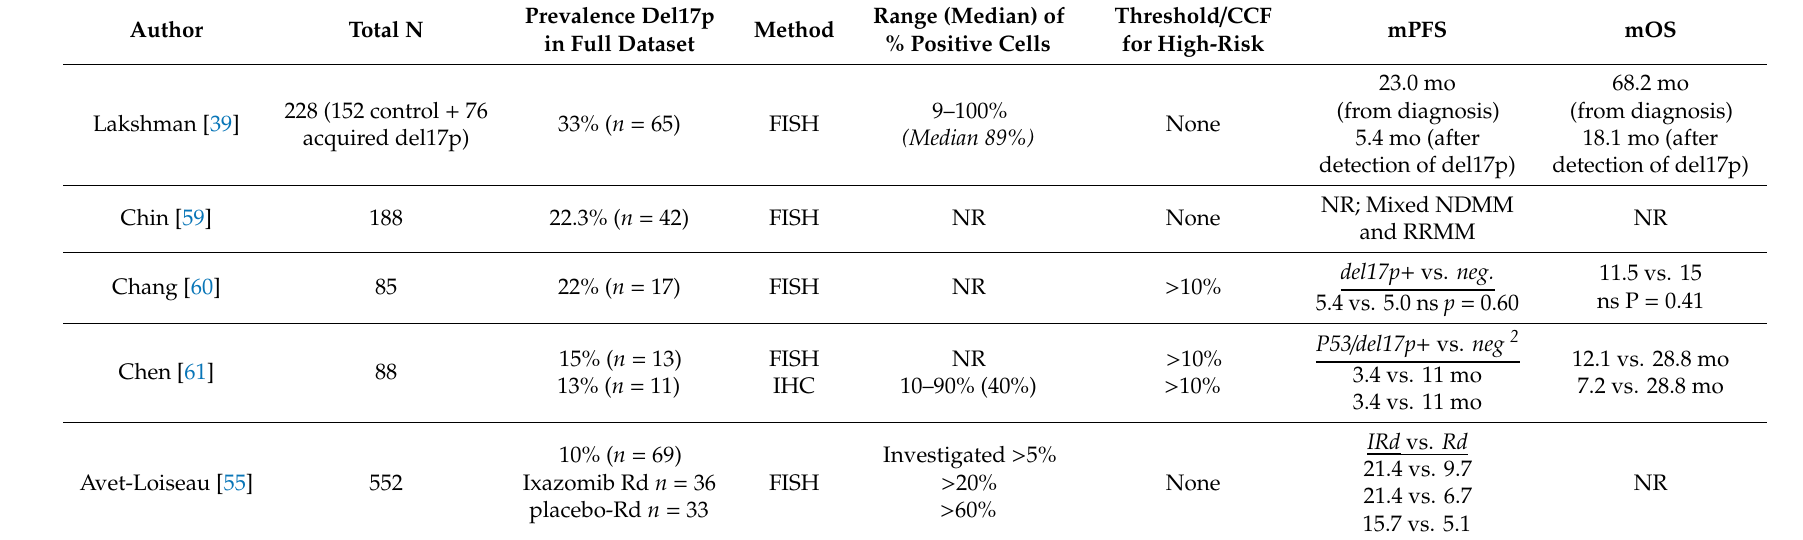
Table 2. Del17p in RRMM Datasets 1